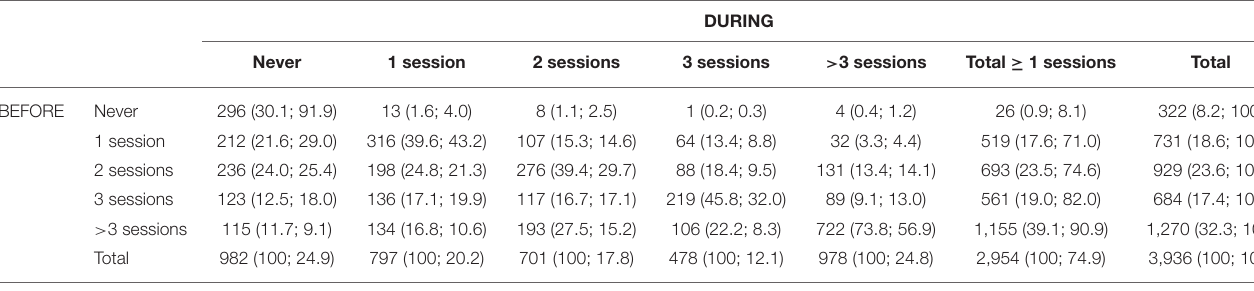
TABLE 8 | Contingency table for comparison of frequency (category percentages for during; category percentages for before) of duration of an individual session of non-organized moderate-to-vigorous physical activity before and during lockdown. DURING ≤ 30 min Total